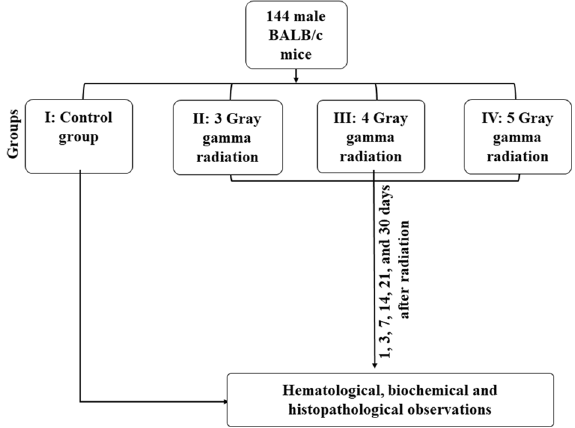
Figure 5. Schematic design of the dosing procedure of the gamma radiation.